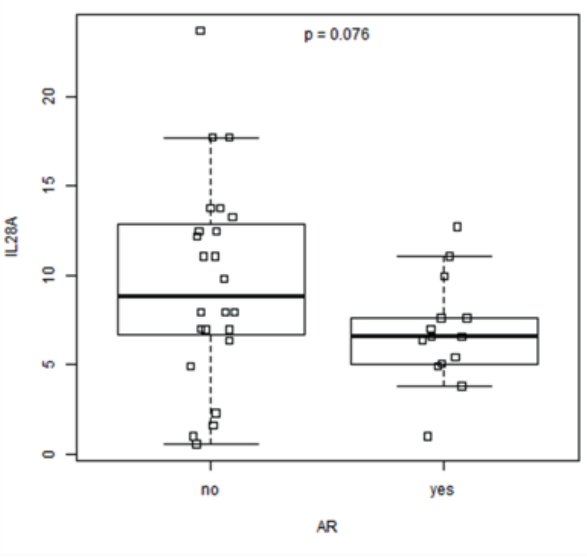
Figure S1: Boxplot combined with strip-chart visualizations that illustrate the IL28A protein expression levels of control (>3 years old) and AR sub- jects, accompanied with the p-value of